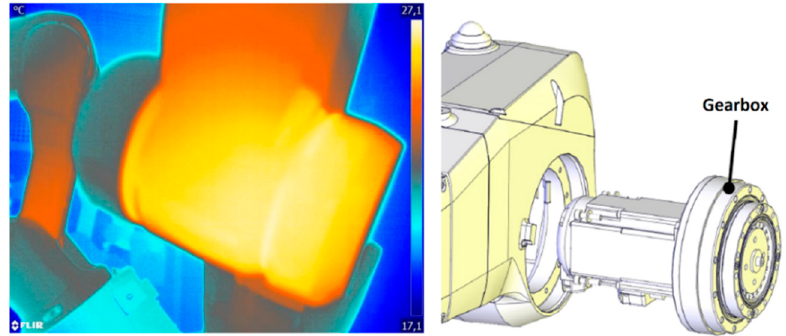
Figure 2. Heat distribution in the gearbox of the third joint of IRB1200 robot.